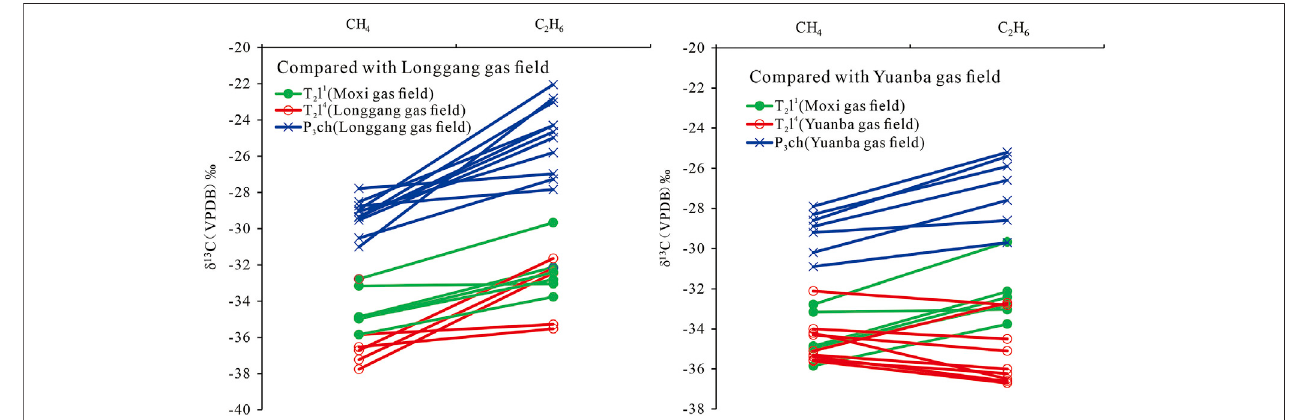
FIGURE 7 | Comparison of δ 13 C 1 and δ 13 C 2 of natural gas in the T 2 l 1 reservoir with T 2 l 4 , P 3 ch and T 1 f reservoirs.